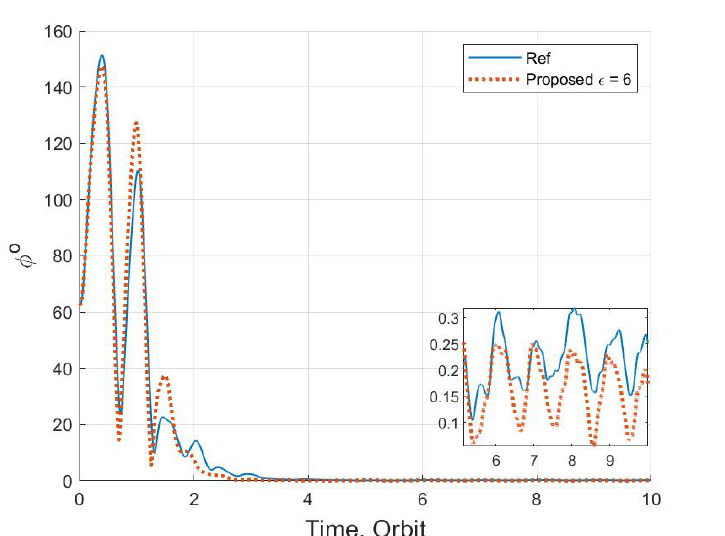
Figure 6. Attitude error history in terms of principal rotation angle φ between the real and desired attitude.